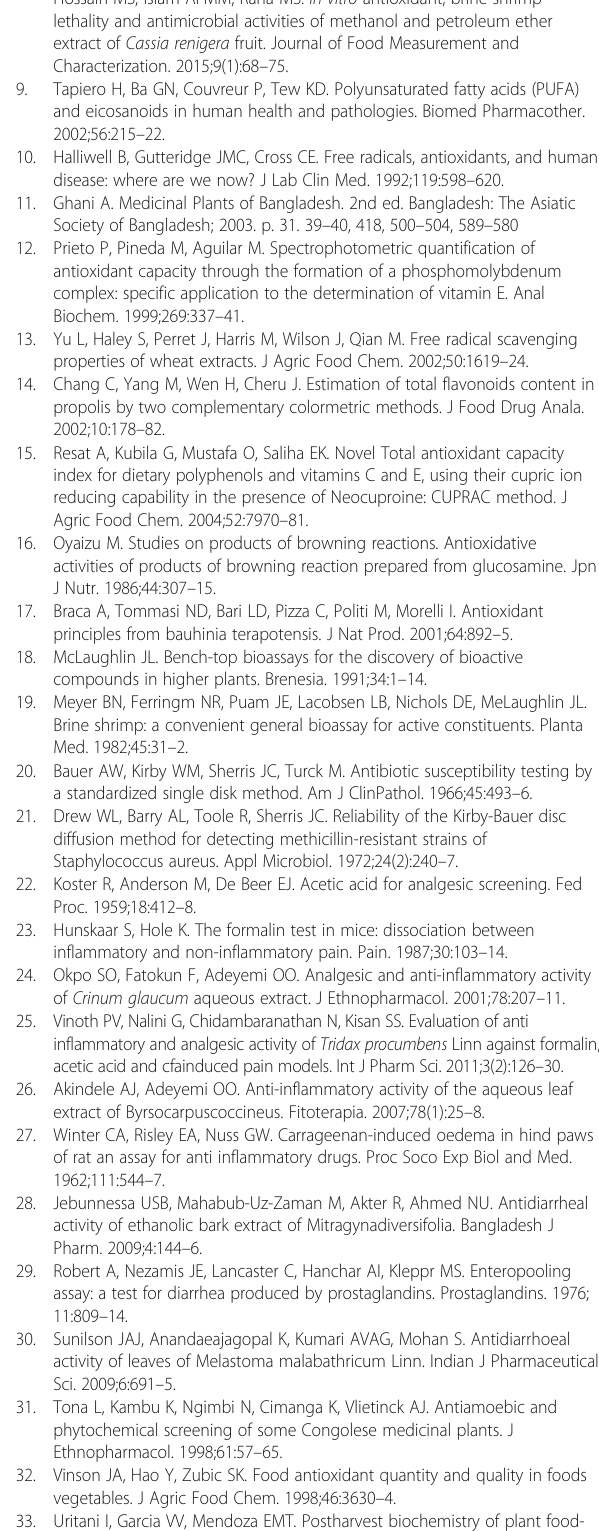
Abbreviations ANOVA: Analysis of variance; DPPH: 1,1-diphenyl-2-picrylhydrazyl; IC 50 : Half maximal inhibitory concentration; LMCA: Leaf methanolic extract of Colocasia affinis Schott; SEM: Standard error of mean; VS: Vincristine